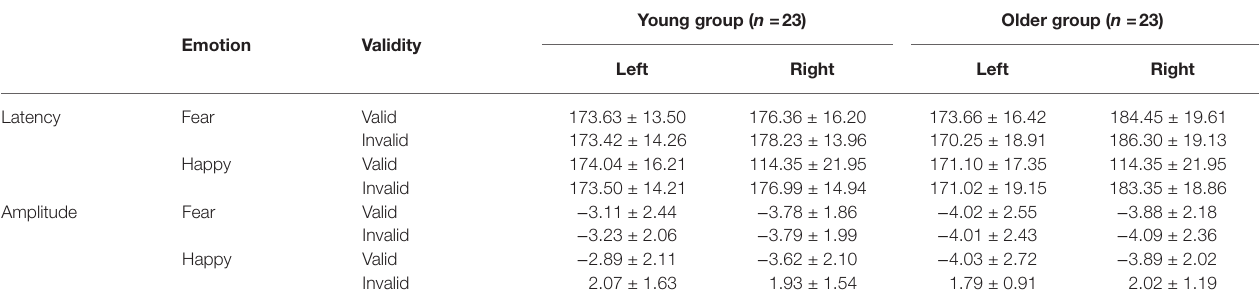
TABLE 4 | Mean latency (ms) and mean amplitude ( μ V) of the N170 ( M ± SD ).